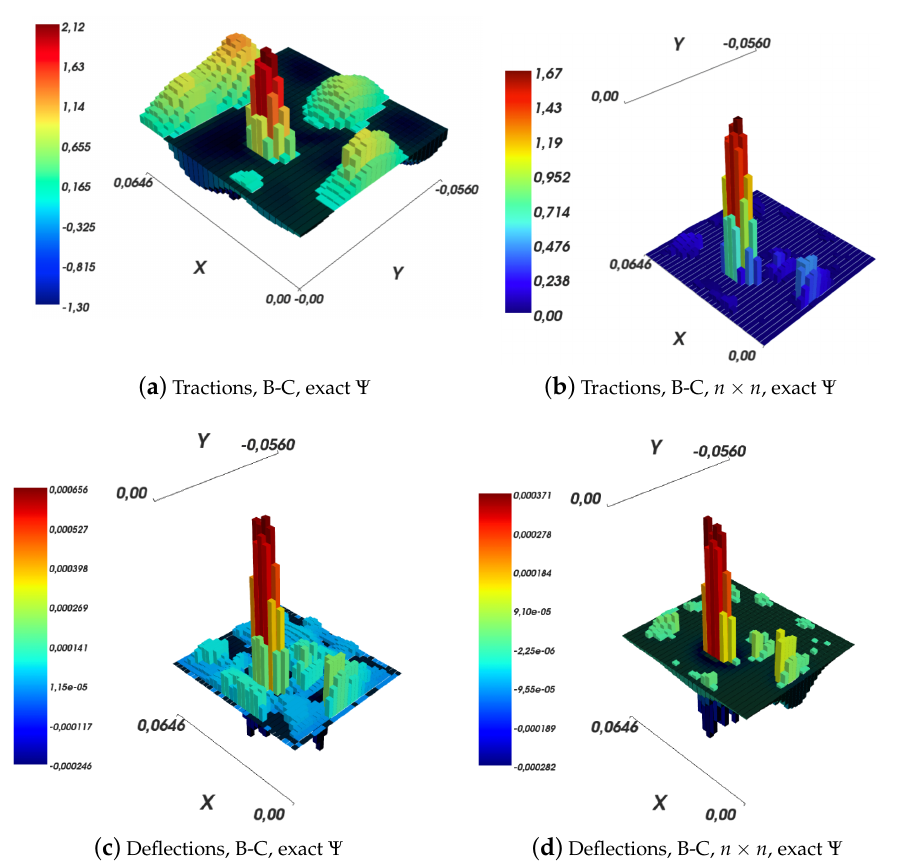
Figure 16. Results in computing the Boussinesq–Cerruti’s solution with the exact formulation for the Ψ